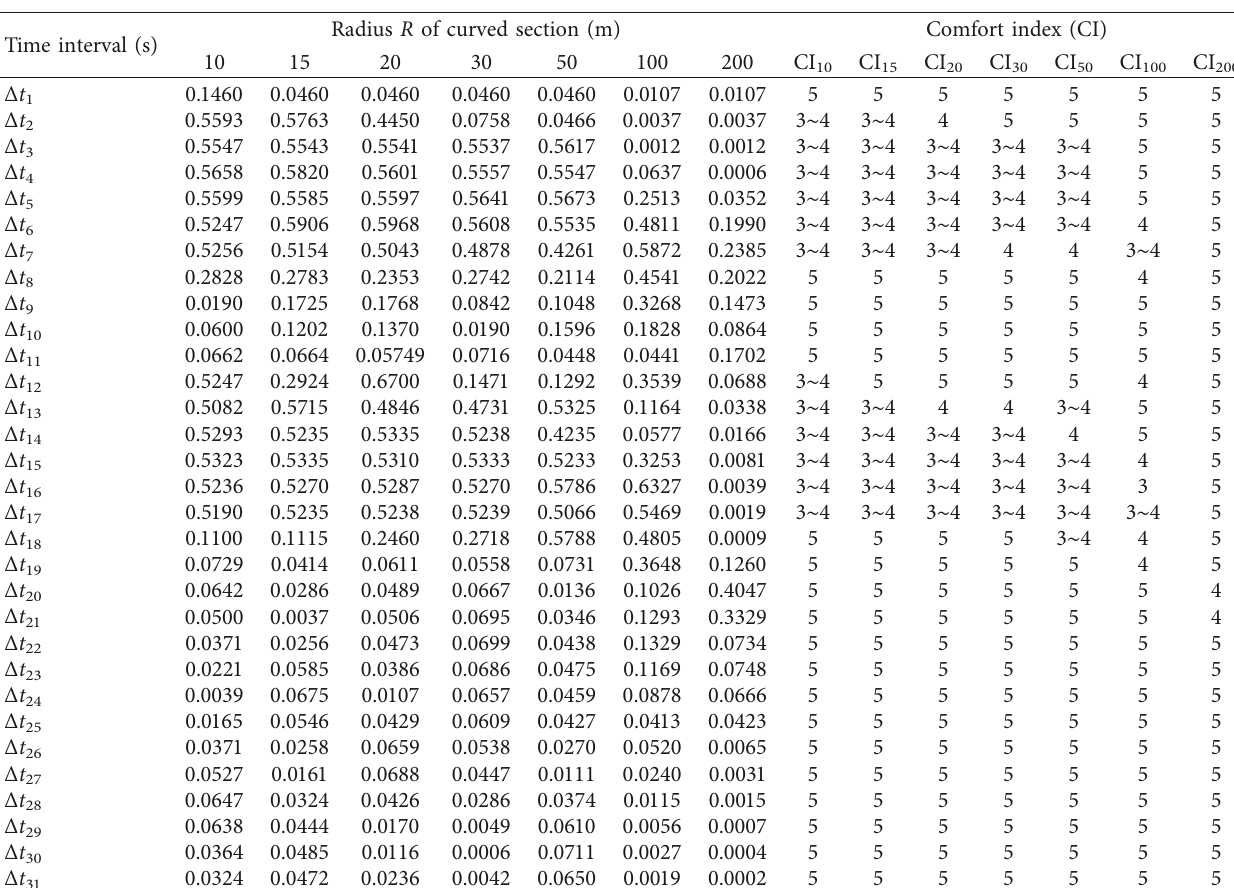
Table 5: Comfort levels with different curve radius under dry road